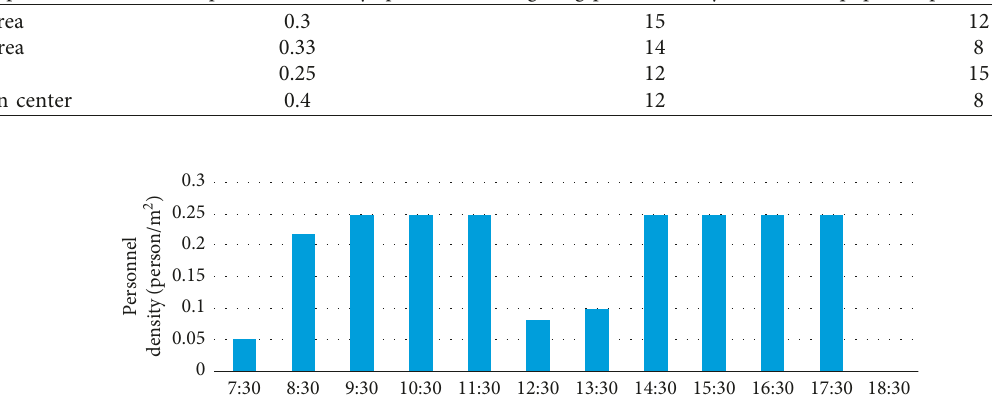
Figure 5: Dynamic change in the staff density in the office area.